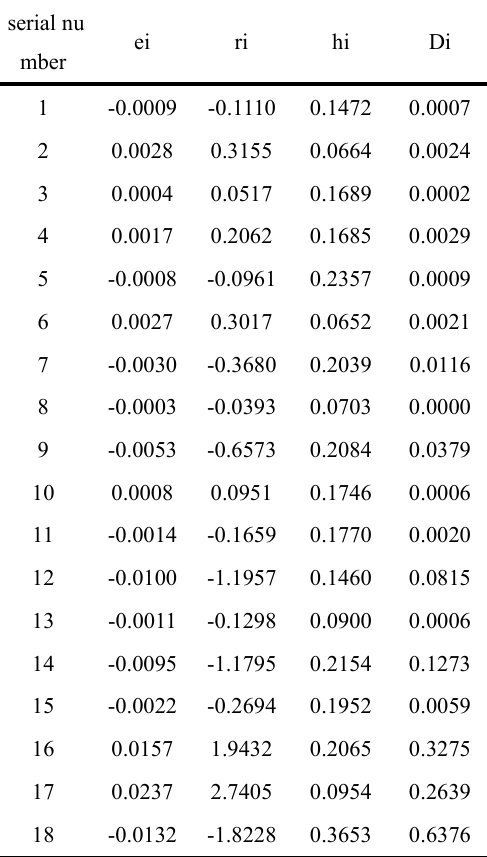
Table 2 Diagnostic statistics of elevation fitting data